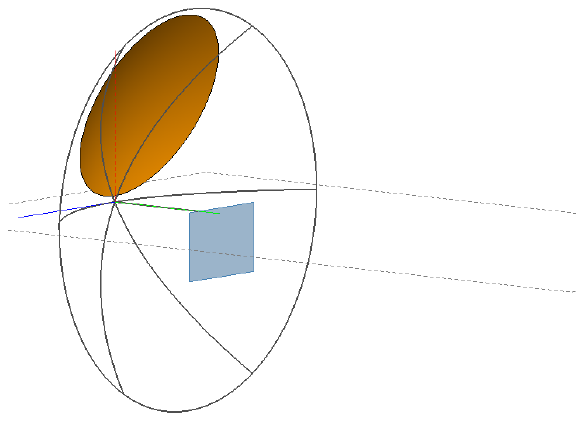
Figure 2. Off-axis parabolic and its focal